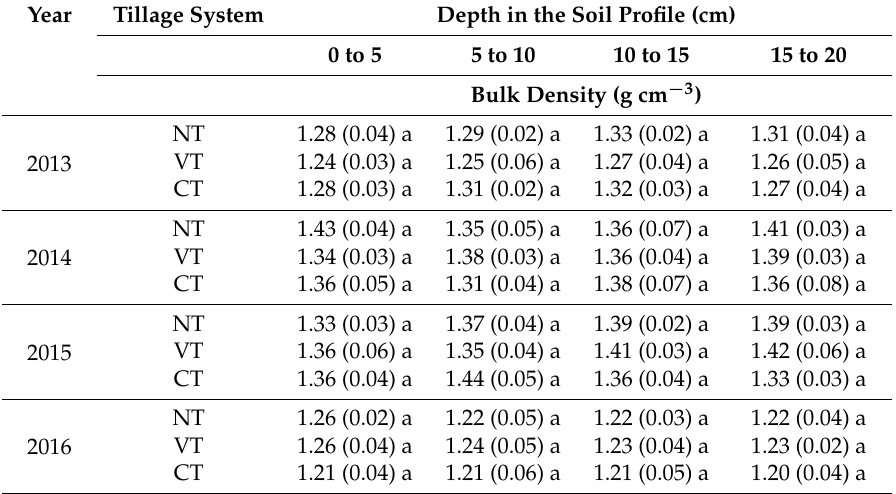
Table 2. Bulk density from 2013 to 2016 in the soil profile for the investigated tillage system. Year Tillage System Depth in the Soil Profile (cm) 0 to 5 5 to 10 10 to 15 15 to 20 Bulk Density (g cm − 3 )